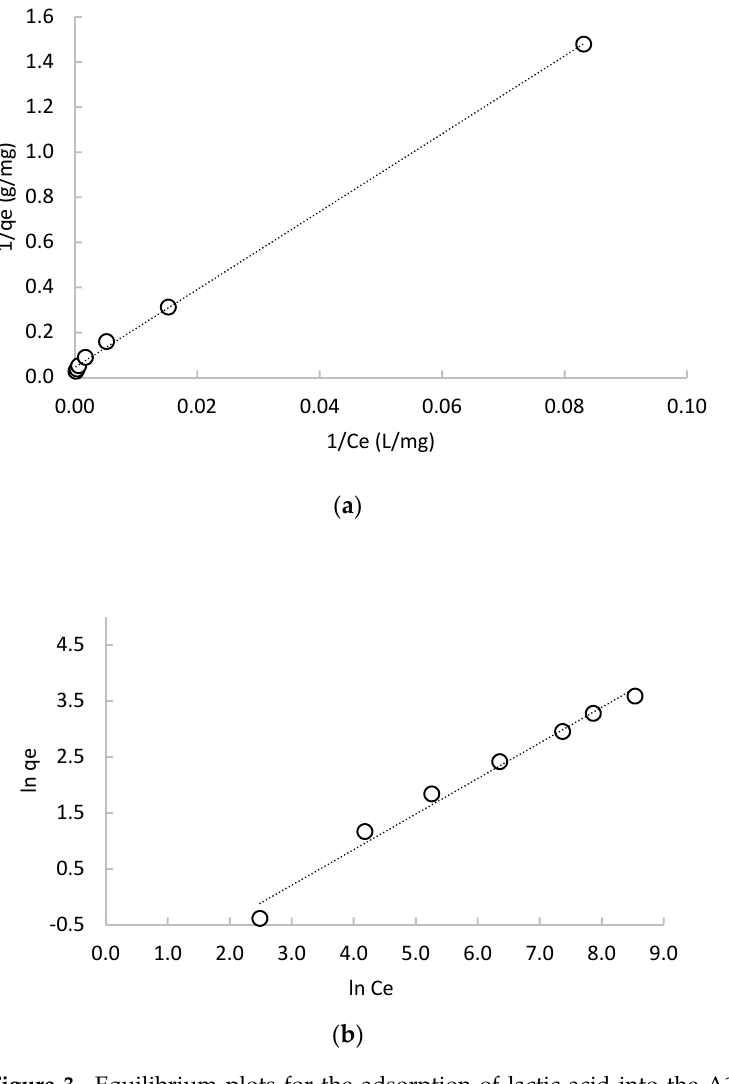
Figure 3. Equilibrium plots for the adsorption of lactic acid into the A100 resin: ( a ) Langmuir isotherm and ( b ) Freundlich isotherm.